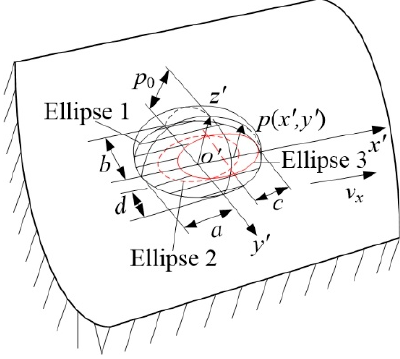
Figure 2. State of contact area